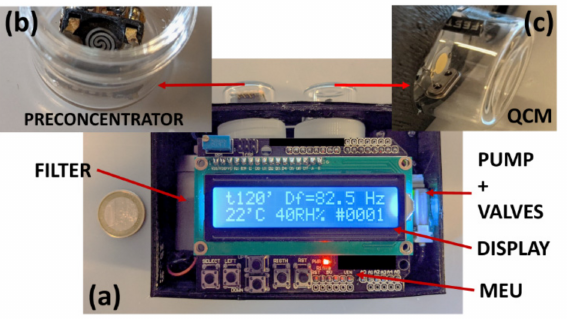
Figure 2. Pictures of the system prototype ( a ). A detail of PreHG ( b ) and QCM sensor ( c ) is reported. The overall dimensions are 90 × 111 × 45 mm with a weight of 250